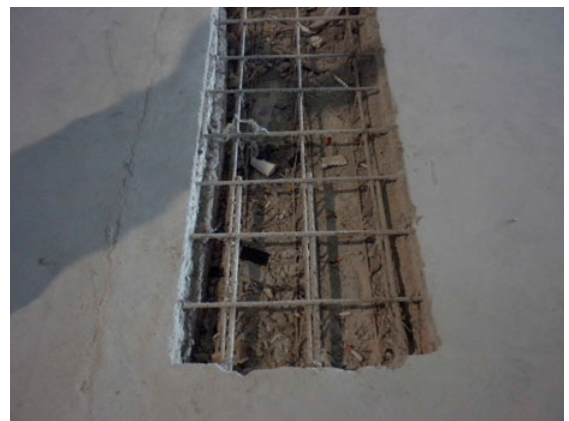
Fig. 3. View of the spatial trusses of composite deck slab